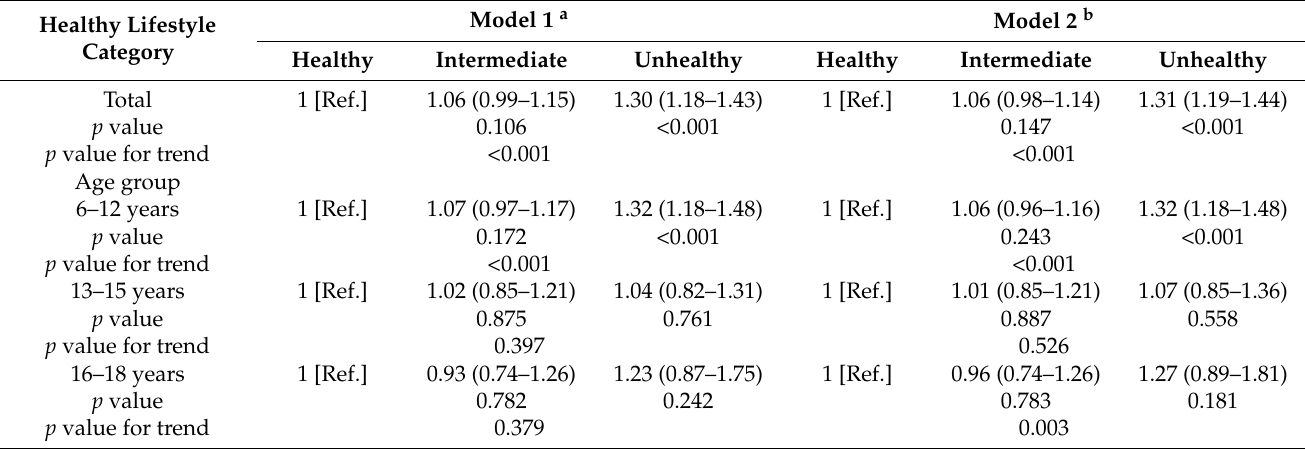
Table 3. Association between lifestyle and obesity in children and adolescents aged 6–18